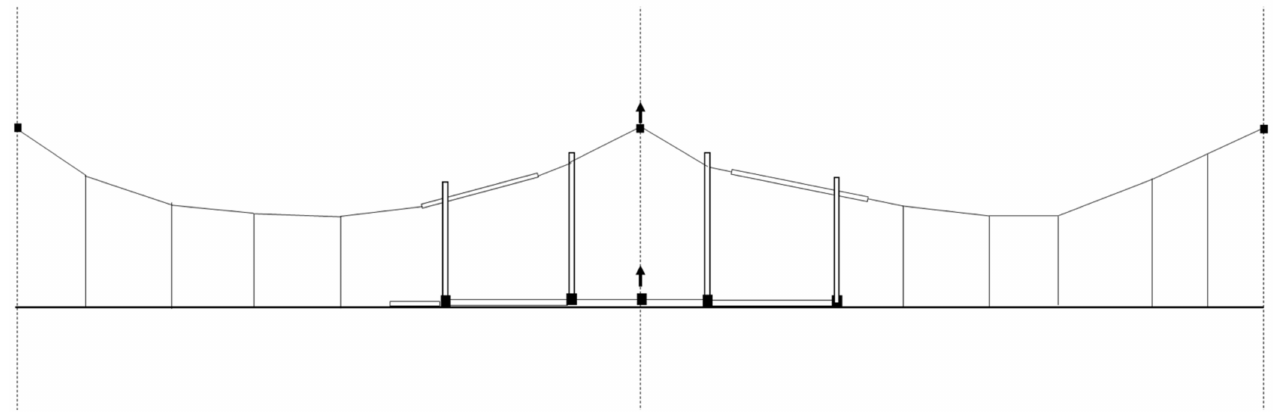
Figure 12. Neutral section installed in a two span section of OCL.